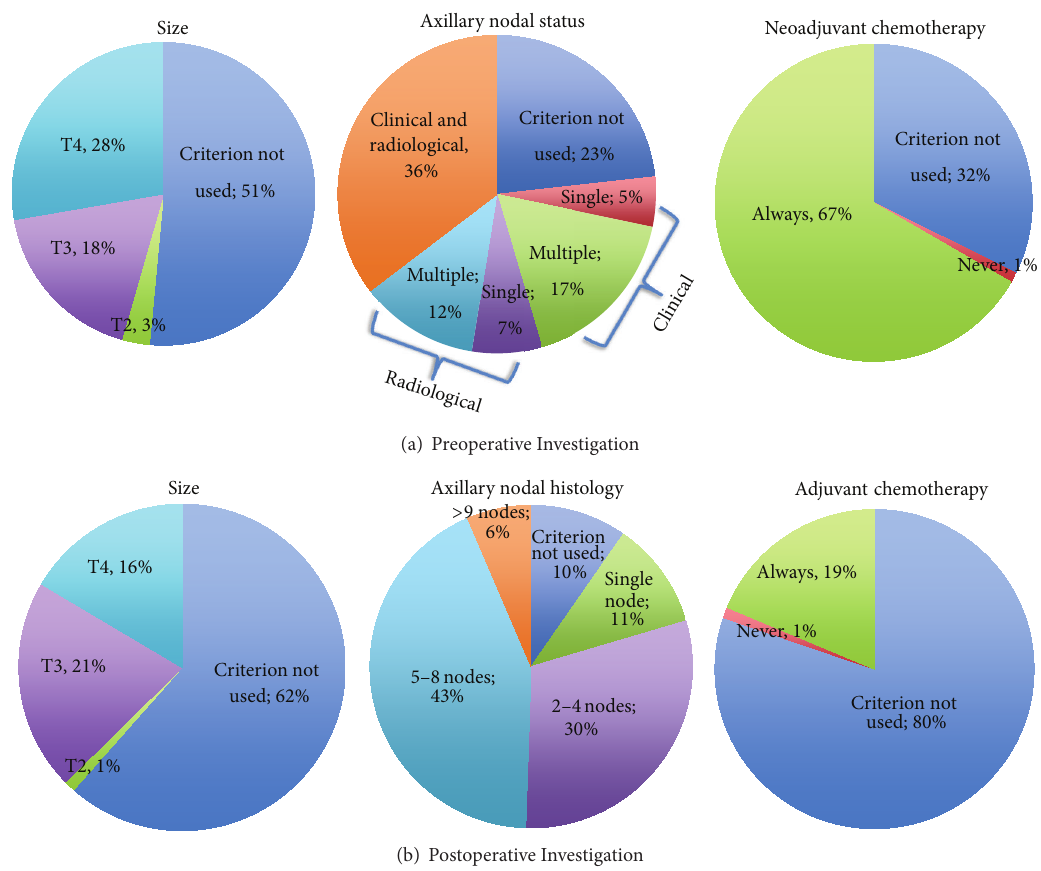
Figure 3: Criteria for pre- and postoperative CT staging for metastatic